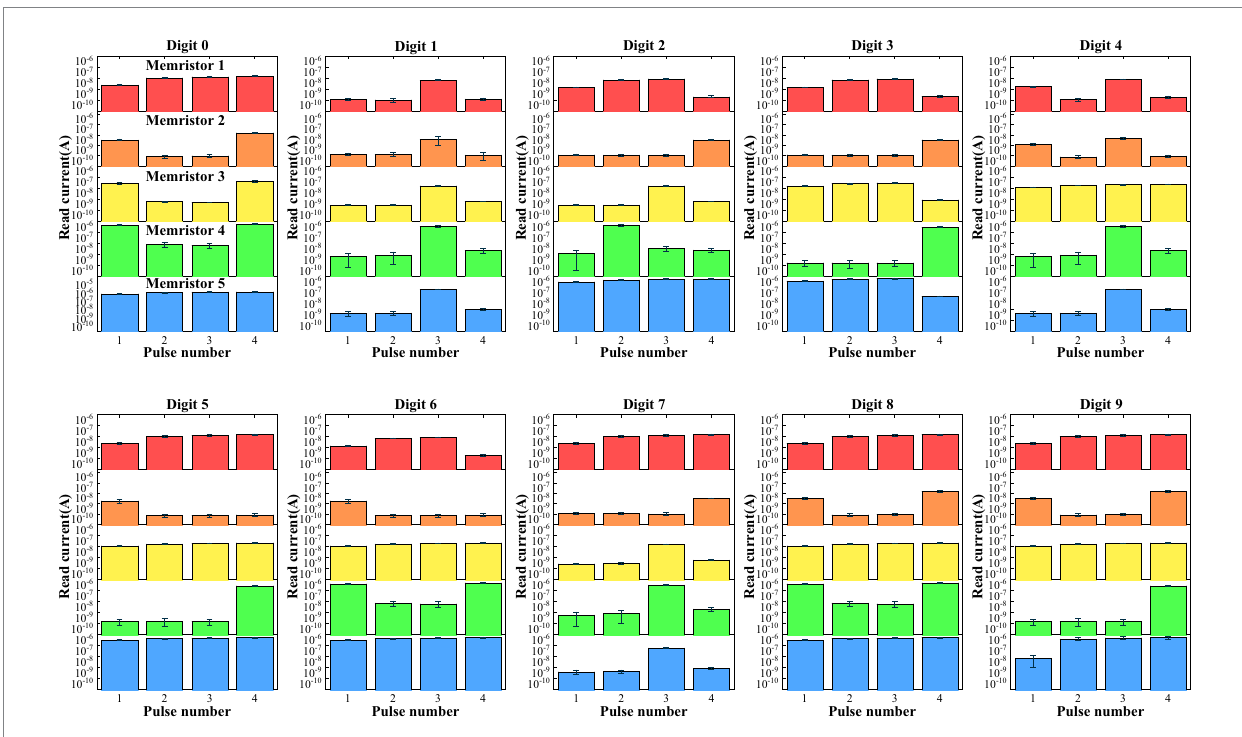
FIGURE 6 Evolutions of the mean currents passing through five memristors upon receiving trains of pulses with different possible patterns. The error bars are standard deviations over 30 test trials.